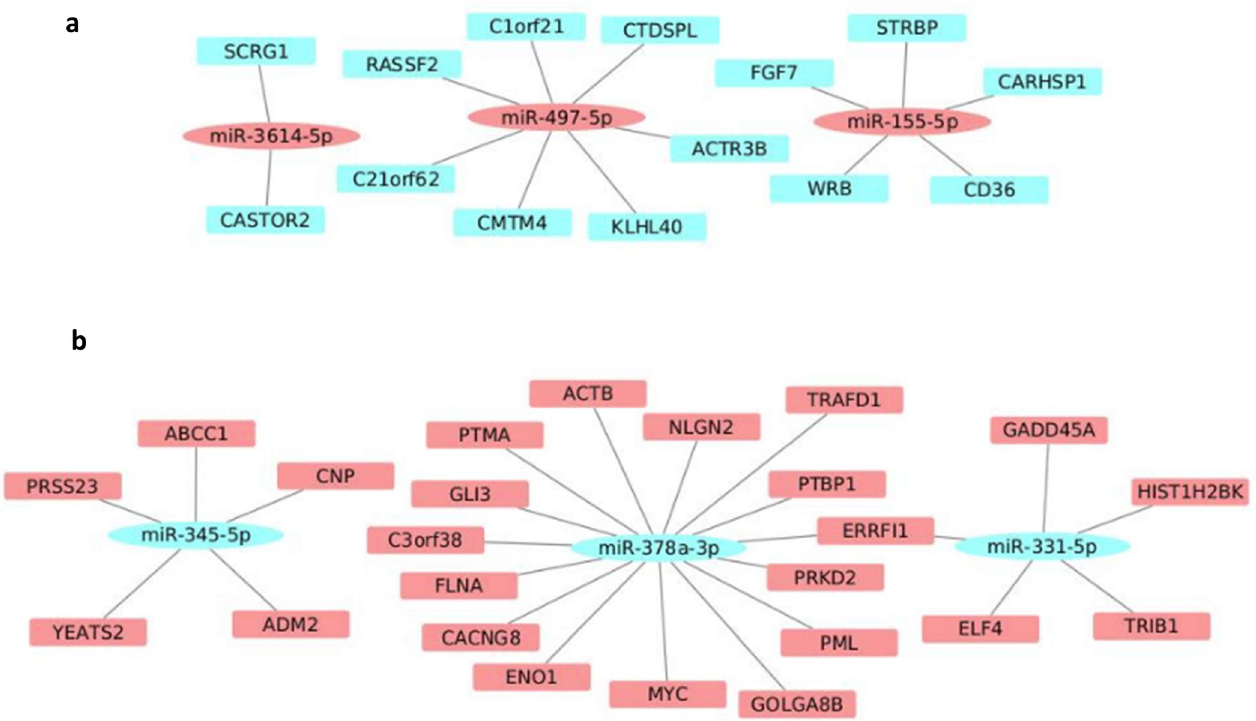
Fig 6. Modulation of miRNAs following in vitro ZIKV infection in human myotubes. ( A ) Network formed by upregulated miRNAs (red ellipses) and their respective targets downregulated (blue rectangles) in myotubes exposed to ZIKV. ( B ) Network formed by downregulated miRNAs (blue ellipses) and their respective targets downregulated (red rectangles) in myotubes exposed to ZIKV. The whole list of differentially expressed miRNAs can be seen in S2 Table.